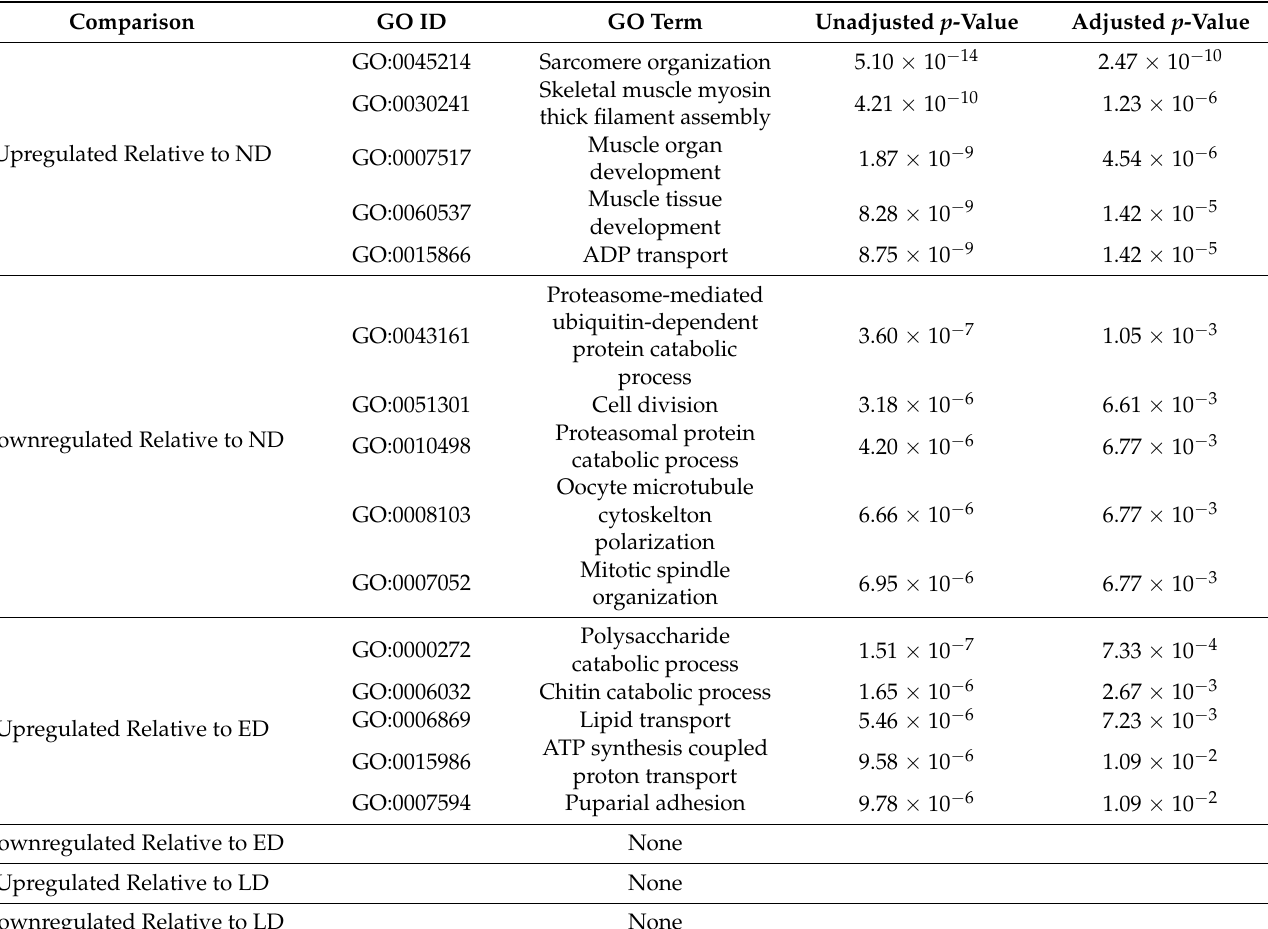
Table 4. Summary of the GO biological processes that are involved in MD. The table shows GO terms that are significantly enriched in differentially expressed transcripts from the MD vs. ND, MD vs. ED, and MD vs. LD comparisons. The top five enriched GO terms among up- and downregulated transcripts for these comparisons are shown. Redundant GO terms were removed using semantic clus- tering with REVIGO. A complete list of enriched GO terms can be found in Supplementary Table